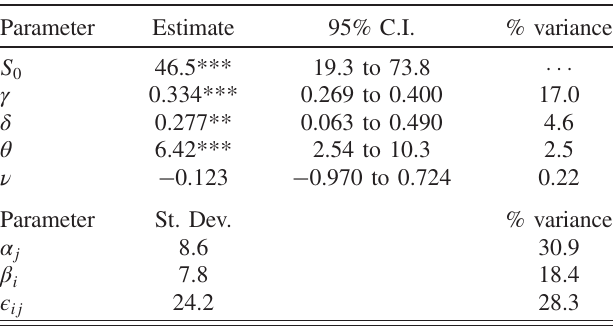
TABLE IV. Estimates of the best fit parameters in model (1). The estimate of each parameter is in units of post-test score (1 – 100) per increment of the parameter, as described in Table III. Here * means p < 0 . 05 , ** p < 0 . 01 , *** p < 0 . 001 . The percentage of variance explained was calculated by the iterative removal of the fixed parameter that explained the most variance, and recalculation of the variance. The data include scores from 133 student participants.